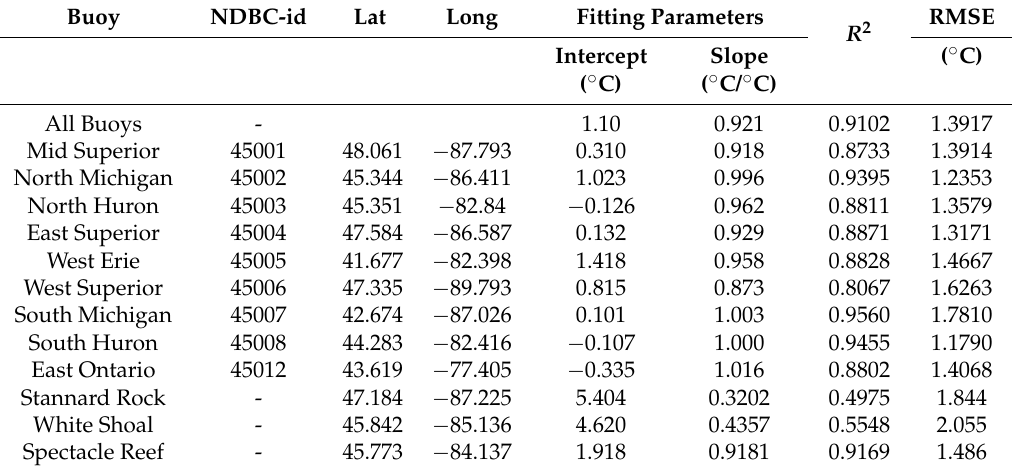
Table 1. Station name and location for water surface temperature measurements and linear regression between MODIS derived skin temperature and surface temperature observed from